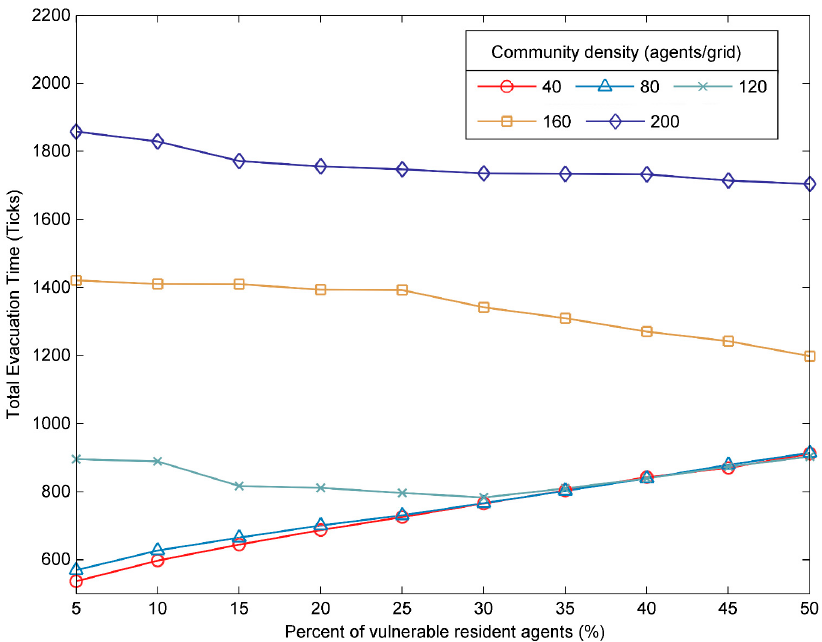
Figure 8. The impacts of the percent of vulnerable resident agents on the total evacuation time.